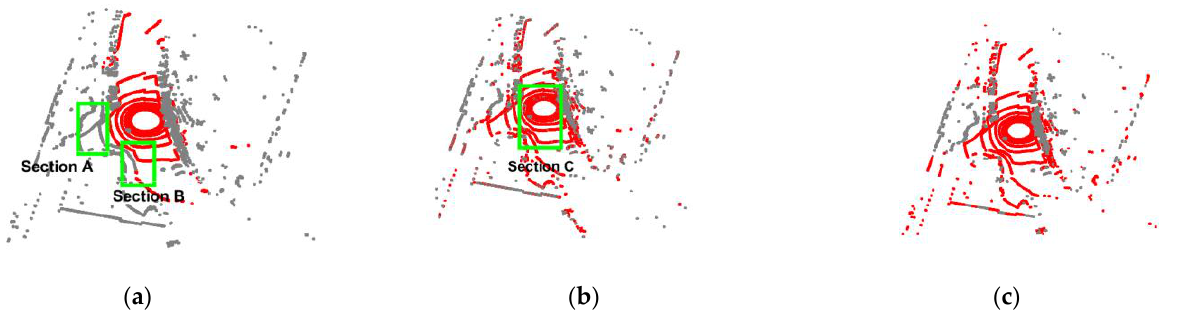
Figure 11. The segmentation effects of various algorithms in the case of slope. ( a ) RANSAC algorithm. ( b ) RGF algorithm. ( c ) Proposed algorithm.